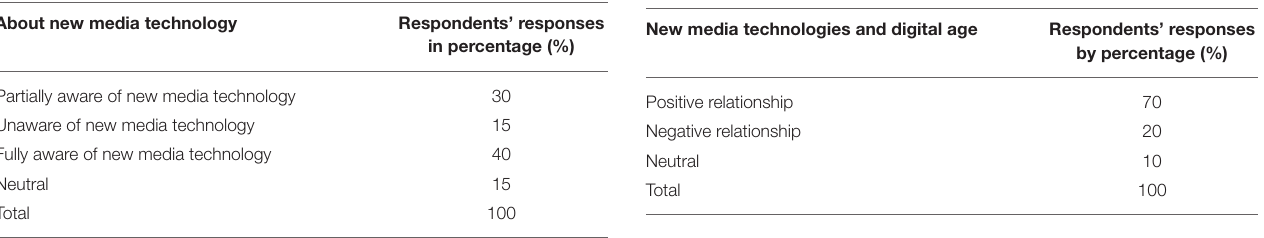
TABLE 5 | New media technology and digital age.